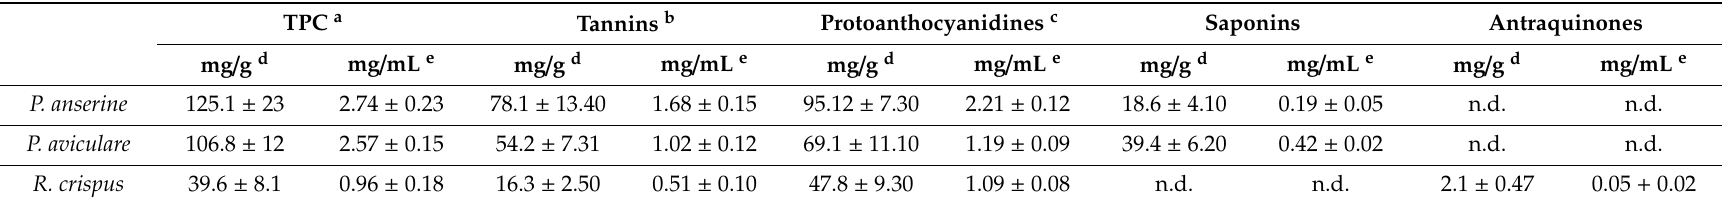
Table 1. Analyzed fractions in herbs and